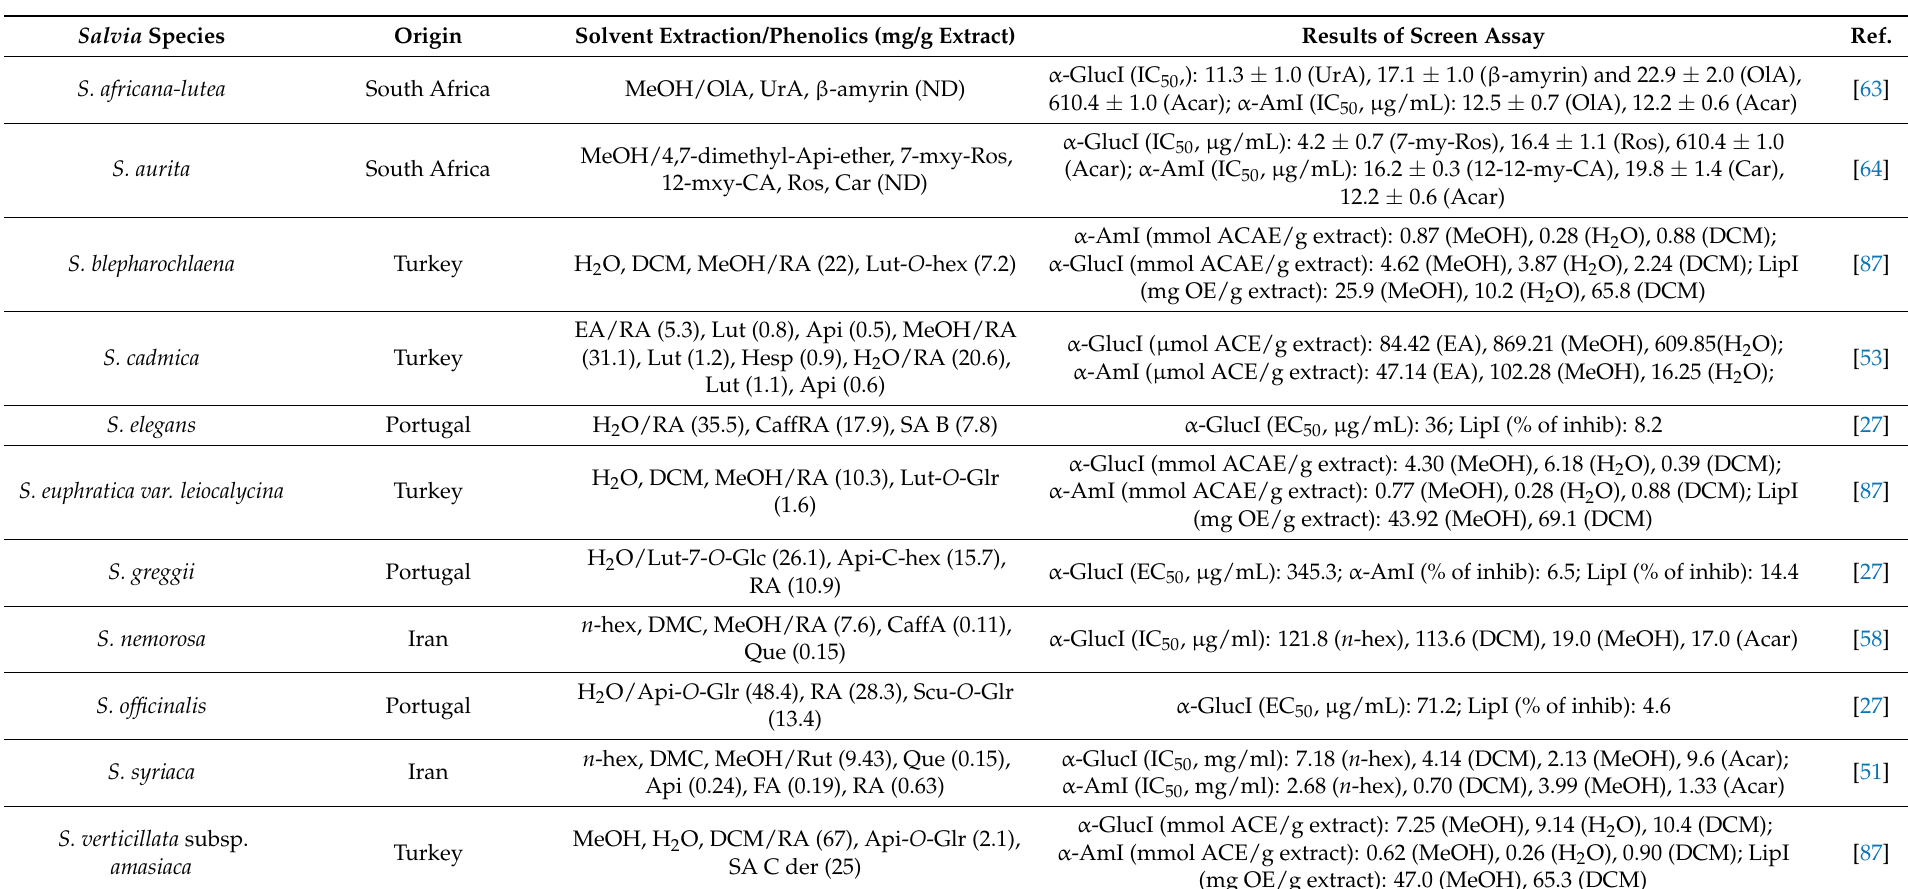
Table 3. Antidiabetic and anti-obesity properties of phenolic-enriched extracts of distinct Salvia species—in vitro